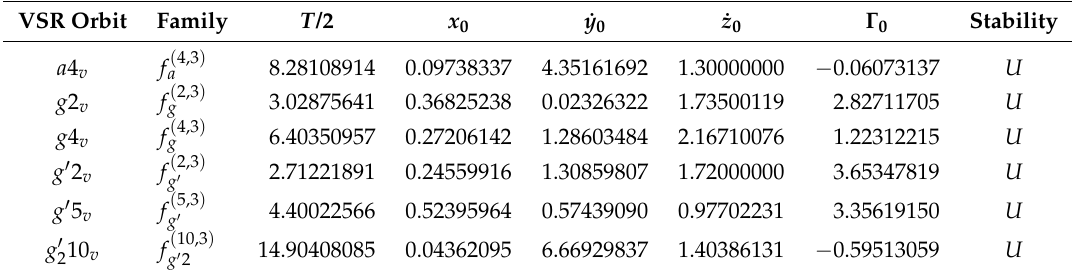
Table 2. Sample members of families of 3D periodic orbits having the O x − O x axis symmetry. These families bifurcate from the VSR orbits as the first column denotes. The last column indicates whether each family contains stable parts ( S ) or not ( U )